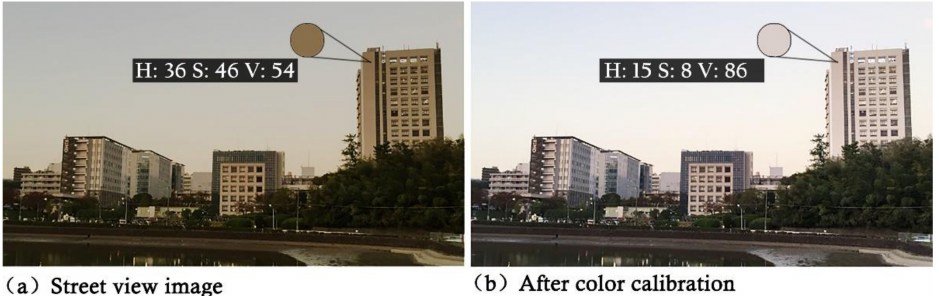
Figure 3. A color calibration demo by AWB and AEC methods. ( a ) original street view image and ( b ) after color